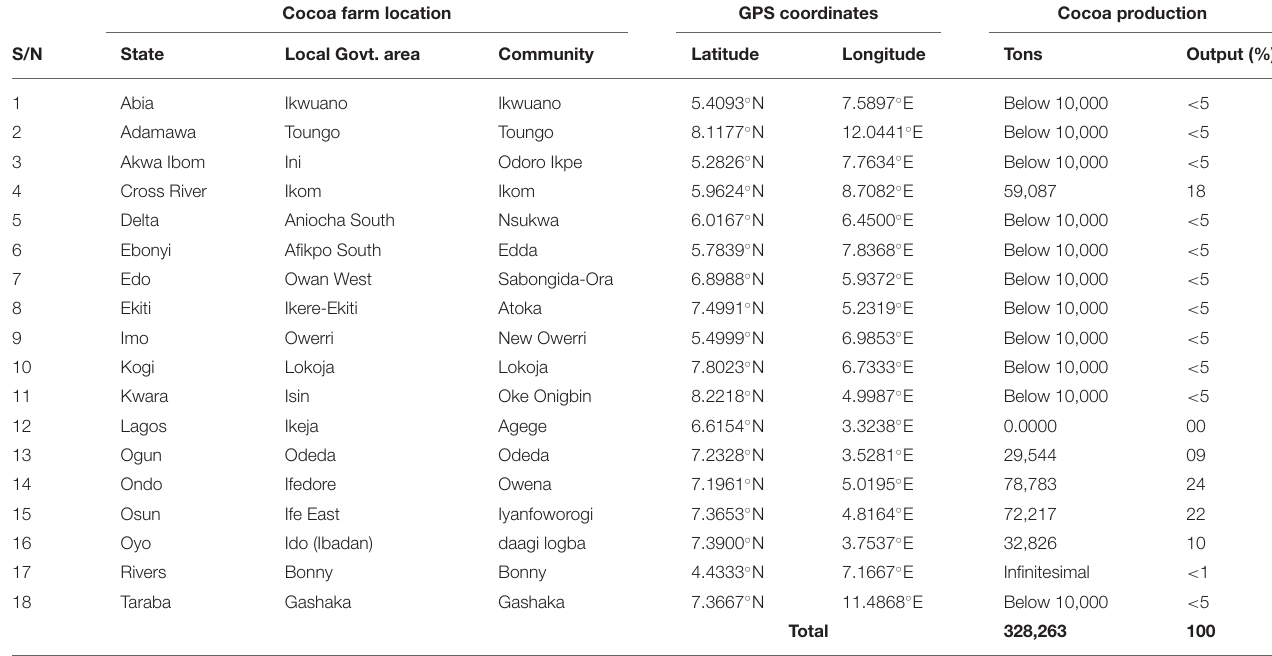
TABLE 2 | The Independent cocoa producing States of Nigeria, GPS location and total output. Cocoa farm location GPS coordinates Cocoa